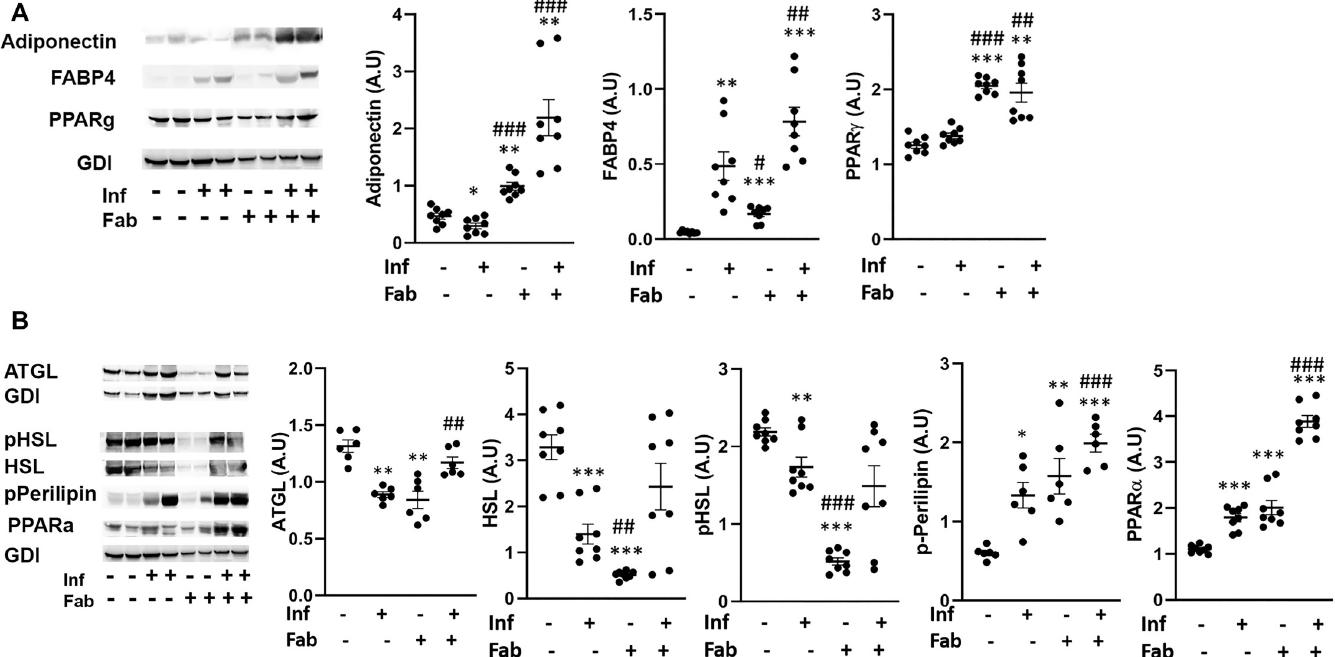
Fig 4. T . cruzi infection and fat ablation alter adipogenesis and lipolysis in adipose tissue during chronic stage in the infected mice. A. Immunoblot analyses of (A) adipogenic markers (adiponectin, FABP4 and PPAR) and (B) lipid degradation markers such as lipases (ATGL, HSL and p-HSL), loss of lipid droplets (p-perilipin) and lipid oxidation (PPAR α ) in adipose tissue of indicated mice (infected or uninfected mice, fat-ablated (Fab +) or fat-unablated (Fab-) n = 8). The change in protein levels were normalized to the levels of Guanosine nucleotide dissociation inhibitor (GDI) and plotted column scatter graph. The error bars represent SEM. A.U. indicates arbitrary unit. � p � 0.05, �� p � 0.01 or ��� p � 0.001 compared with uninfected fat-unablated. # p � 0.05, ## p � 0.01 or ### p � 0.001 compared with infected